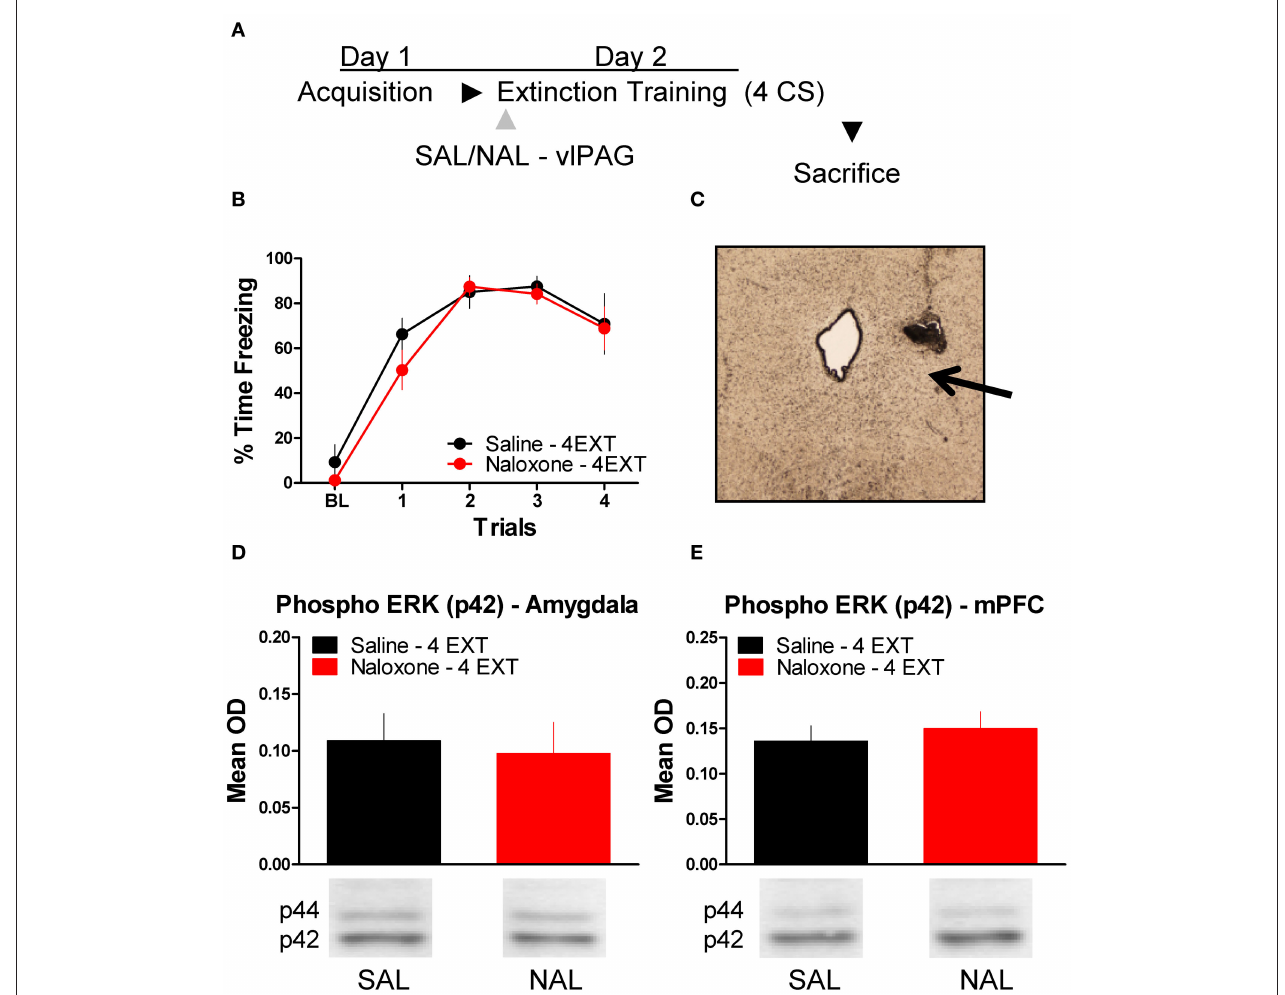
Figure 5 | Opioid receptor blockade does not affect erK phosphorylation following four trials of extinction. (A) Schematic showing the behavioral procedures employed in this experiment. (B) Freezing during the four trials of extinction training. (C) Representative image taken using Nomarski optics at